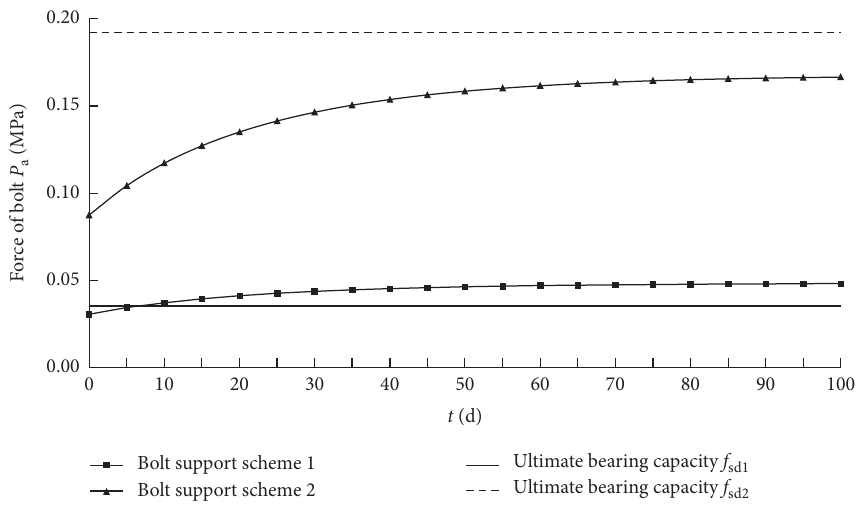
Figure 5: Radial force variation of the bolt with time.